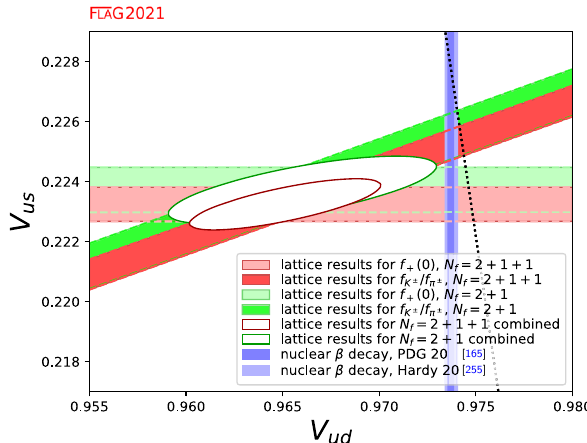
Fig. 10 The plot compares the information for | V ud | , | V us | obtained on the lattice for N f = 2 + 1 and N f = 2 + 1 + 1 with | V ud | extracted from nuclear β transitions Eqs. (71) and (72). The dotted line indicates the correlation between | V ud | and | V us | that follows if the CKM-matrix is unitary. For the N f = 2 results see the 2016 edition